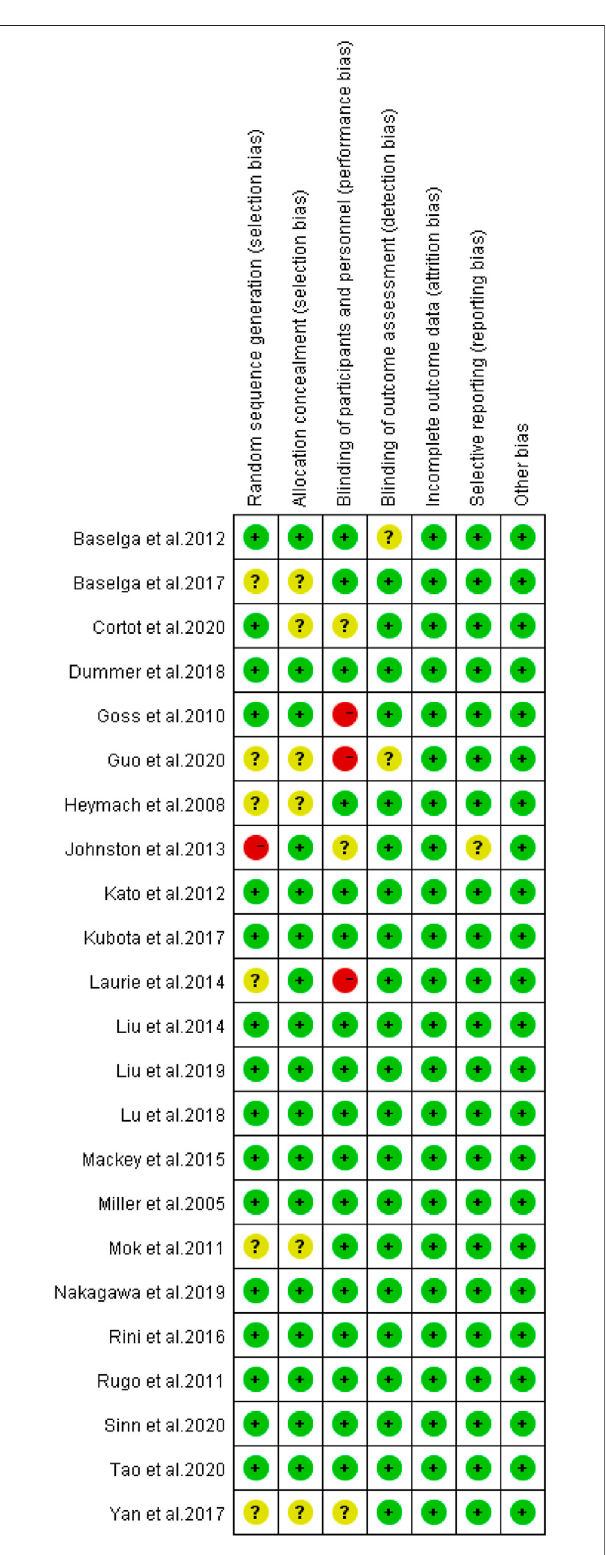
FIGURE 9 | Risk of bias of included randomized controlled trials